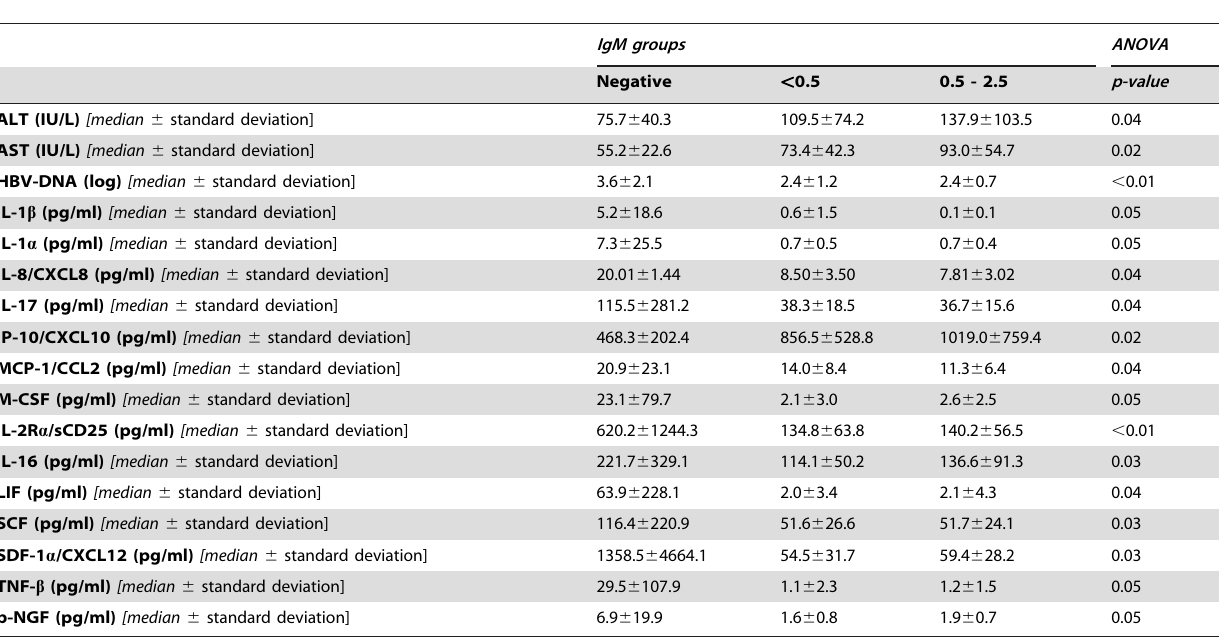
Table 4. Factors univariatly associated with the groups of anti-HDV IgM based on ANOVA analysis.